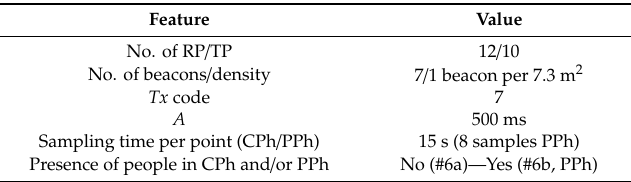
Table 17. Main features of Tests #6.